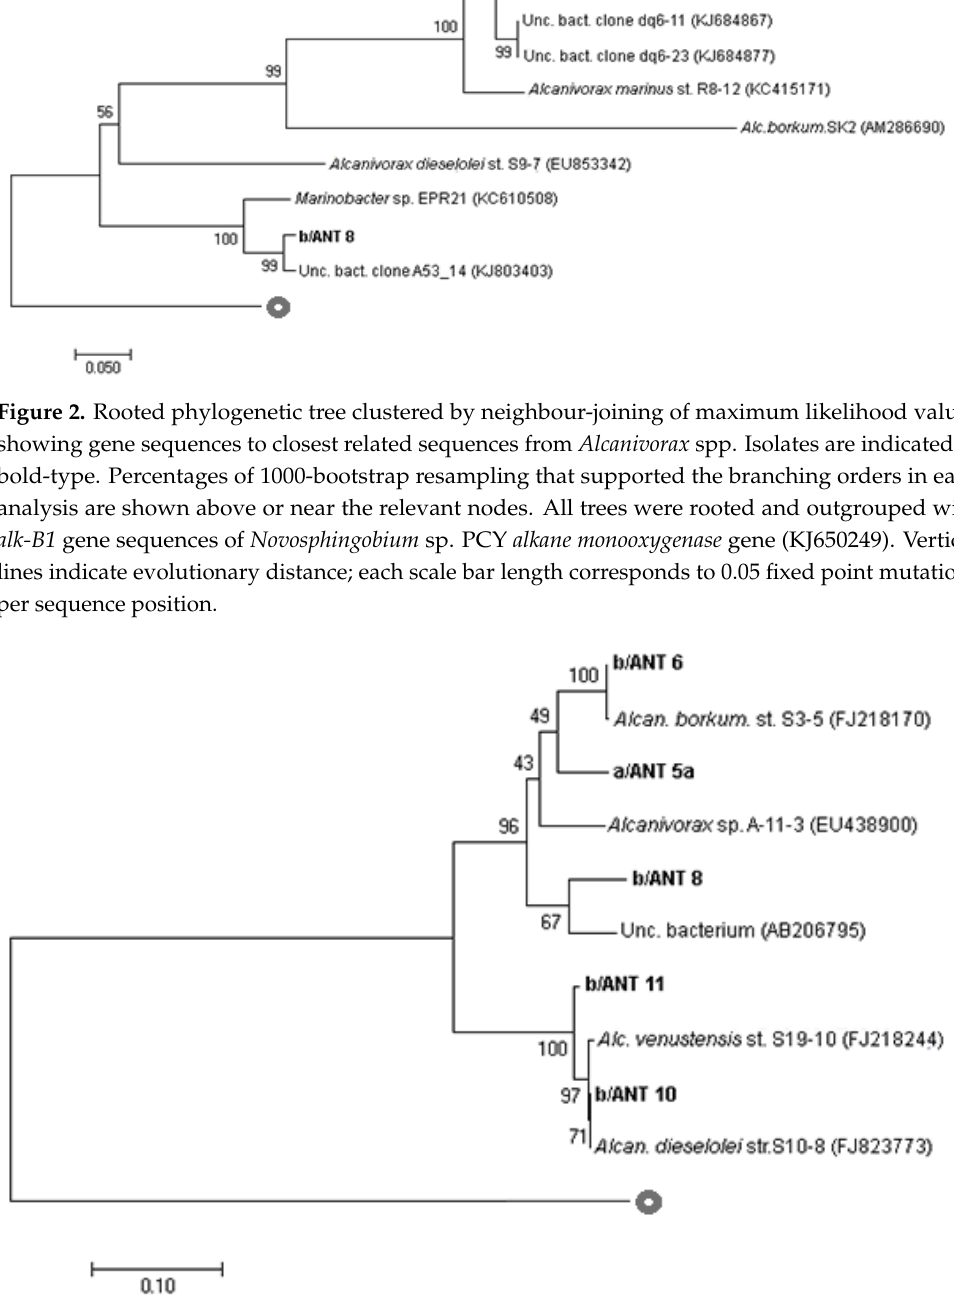
Figure 3. Rooted phylogenetic tree clustered by neighbour-joining of maximum likelihood values showing affiliation of P450 gene sequences to closest related sequences from Alcanivorax spp. Isolates are indicated in bold-type. Percentages of 1000-bootstrap resampling that supported the branching orders in each analysis are shown above or near the relevant nodes. All trees were rooted and outgrouped with P450 gene sequences of Novosphingobium sp. SB32149 gene for P450 (LC214353). Vertical lines indicate evolutionary distance; each scale bar length corresponds to 0.05 fixed point mutations per sequence